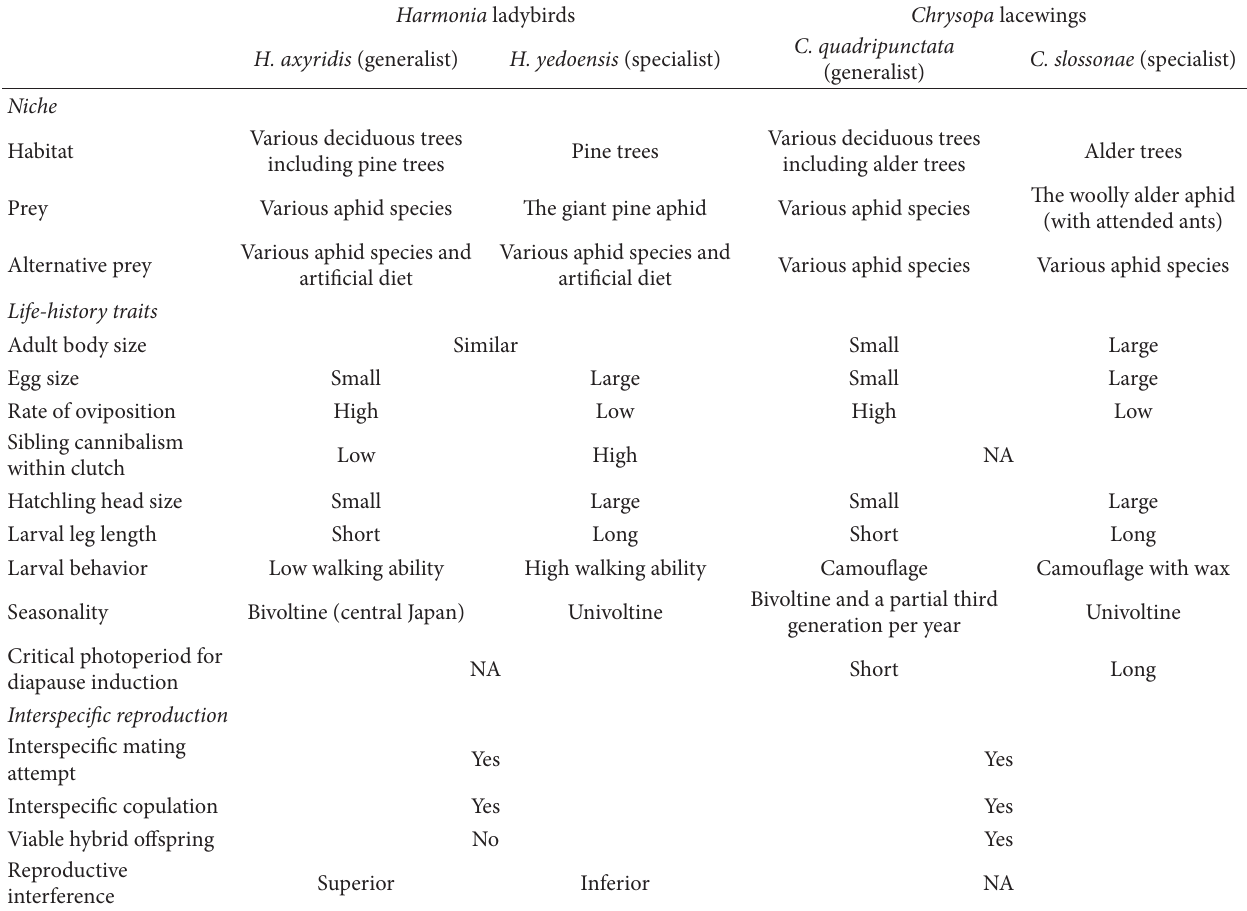
Table 1: Comparison of the niche, life-history traits, and interspecific mating interactions in sibling species between Harmonia ladybirds and Chrysopa